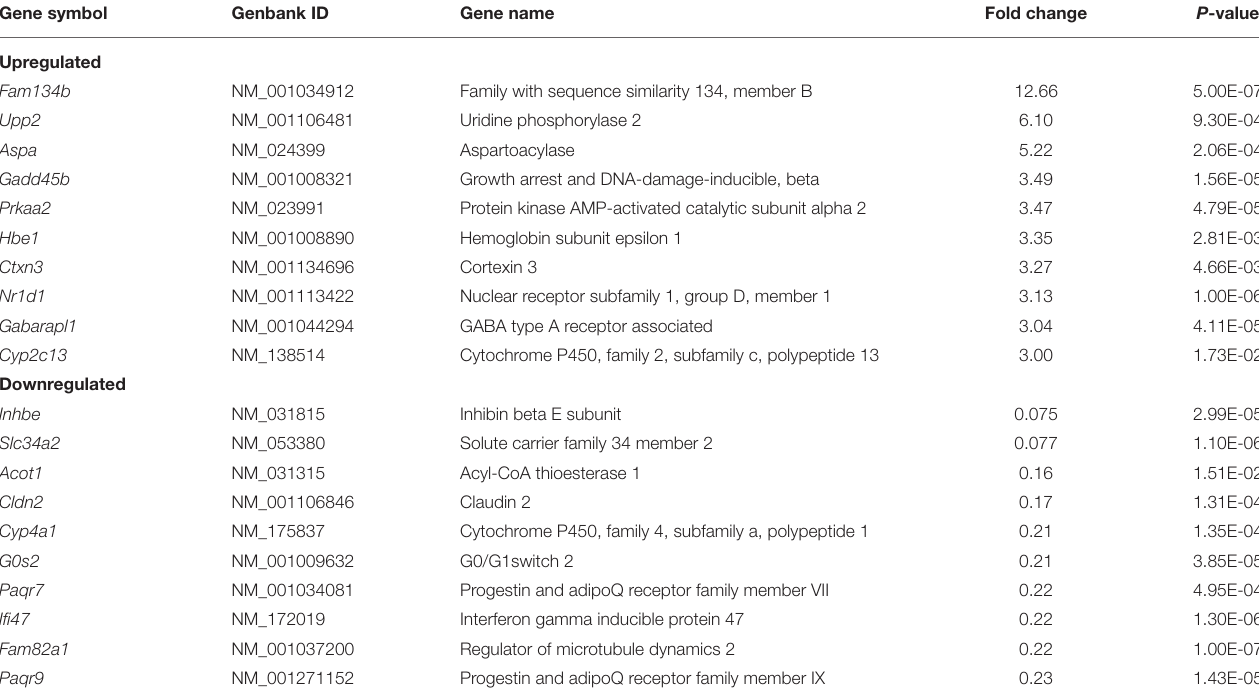
TABLE 1 | The top 10 regulated differentially expressed genes between IUGR and